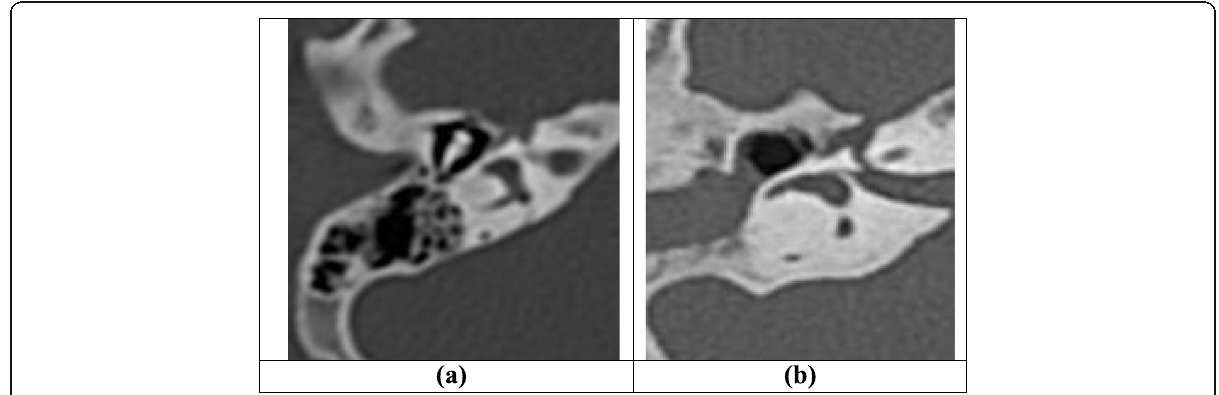
Fig. 2 Type-III-non-visualized: in the absence of opacification ( a ) and in the presence of opacification ( b